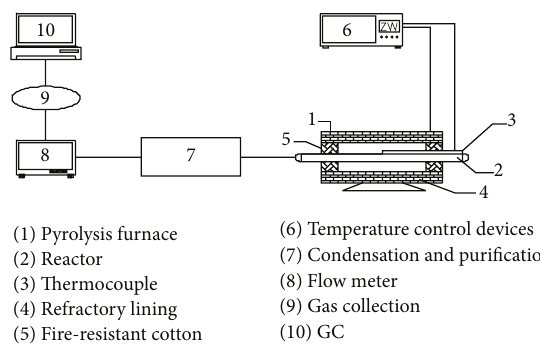
Figure 1: The schematic diagram of the pyrolysis reactor.